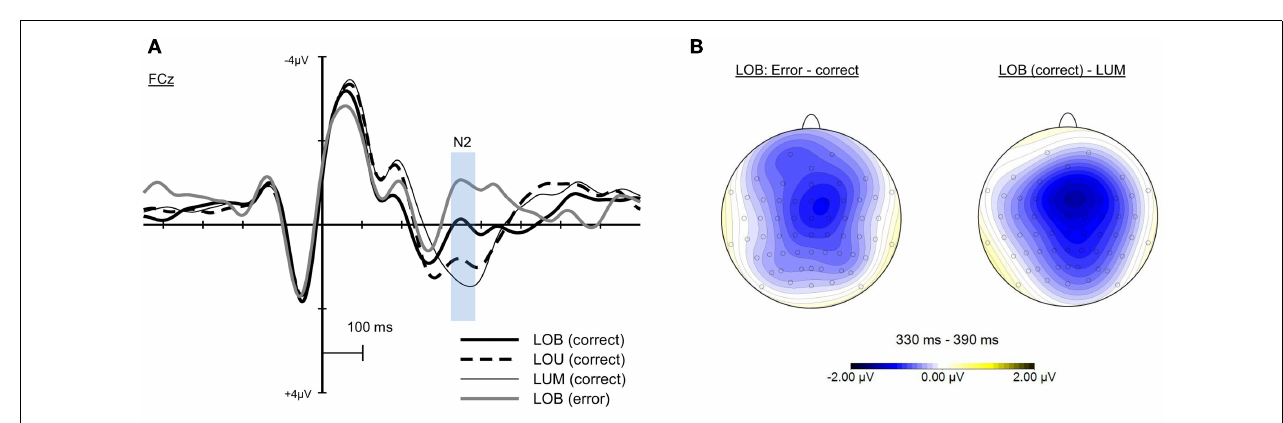
for erroneous compared to correct change detection. (B) shows the scalp distribution of the difference waves for correct and erroneous change detection in the LOB condition (error – correct) and for the LOB and LUM change condition (LOB – LUM) in the N2 time window. Both the Error-Correct and the LOB-LUM different waves indicated a fronto-central scalp distribution in the N2 time